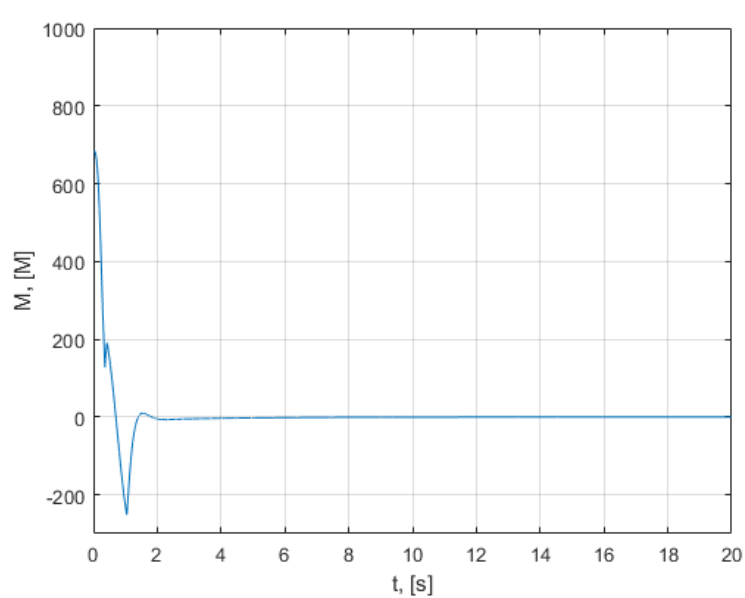
Figure 19. Figure 19. Torque.